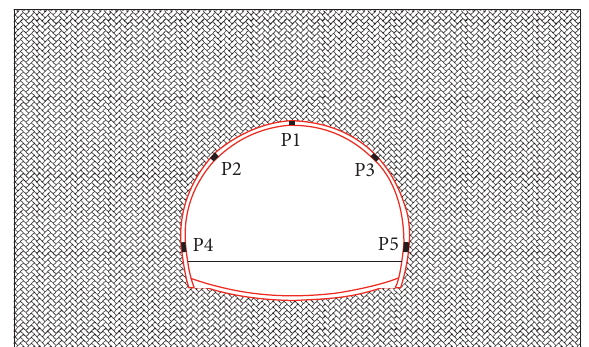
Figure 7: Layout of stress measuring points of the surrounding rock, the borehole depth L � 8.0m and aperture Φ 70mm.